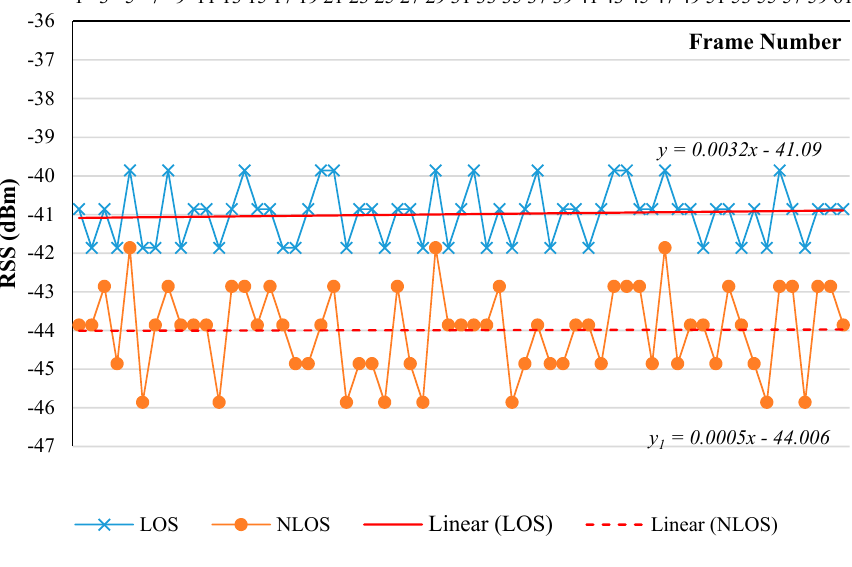
Figure 10. Wall attenuation factor (WAF) estimation.